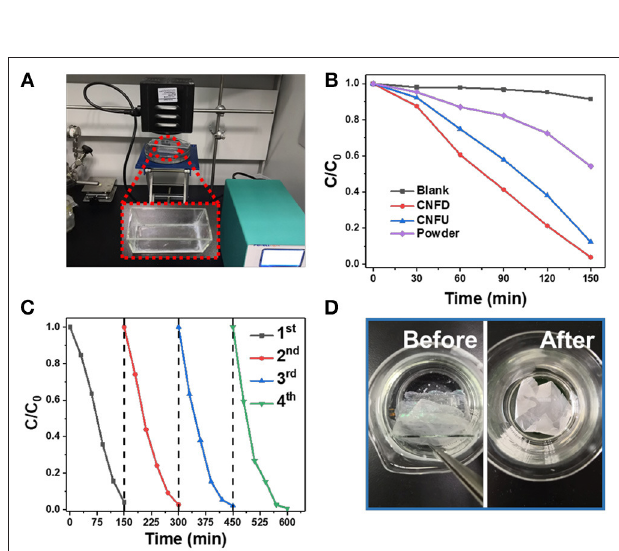
FIGURE 4 | Optical CA images of water on the g-C 3 N 4 film, (A) CNFD, (B) CNFU.